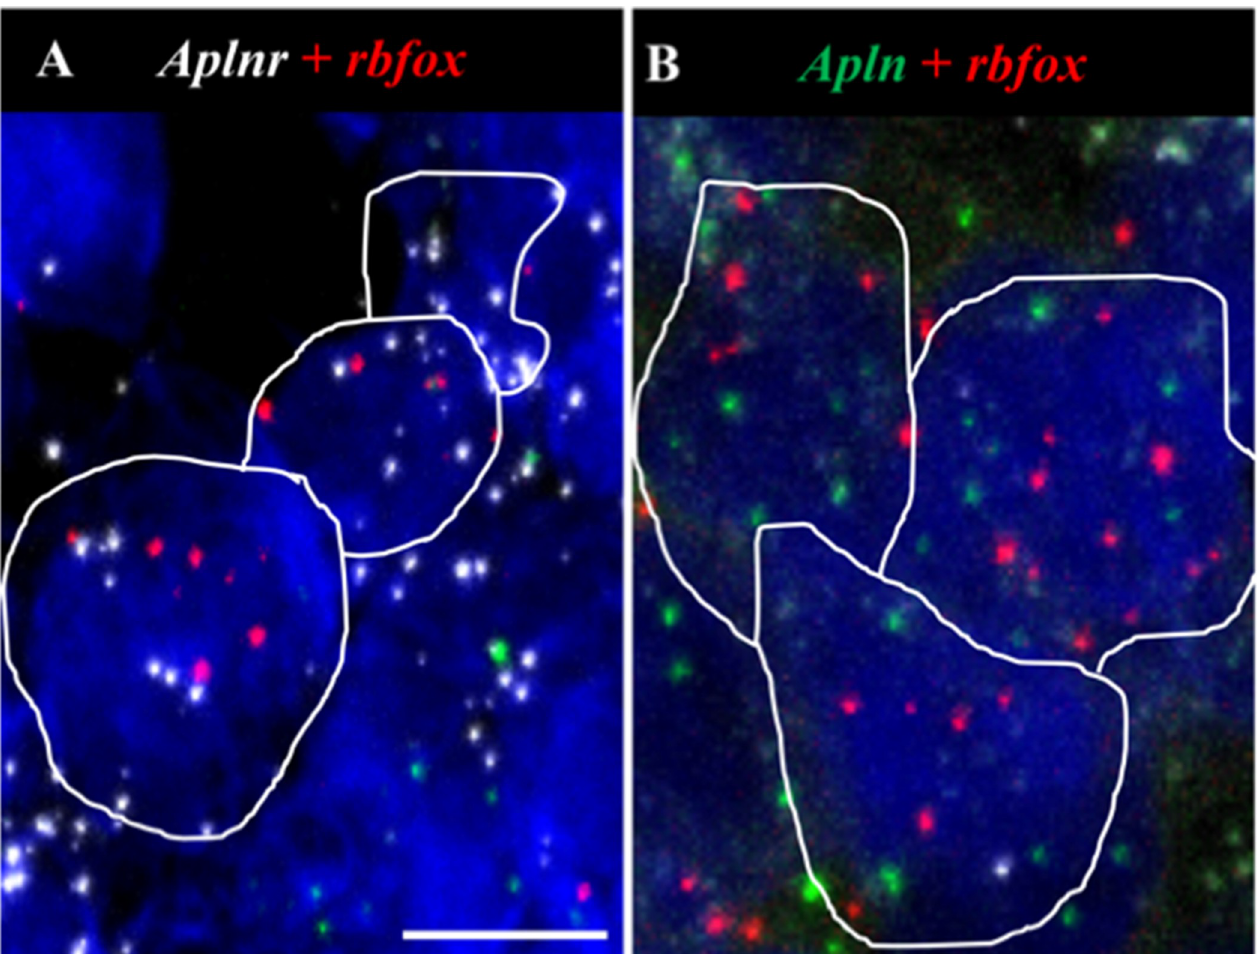
Fig 5. Aplnr and apln transcripts co-localise with rbfox in the AP. (A,B) Representative fluorescent images showing colocalization of aplnr (white dots, A) and apln (green dots, B) with rbfox (red) in the AP. Scale bar = 10 μ m. n = 4.